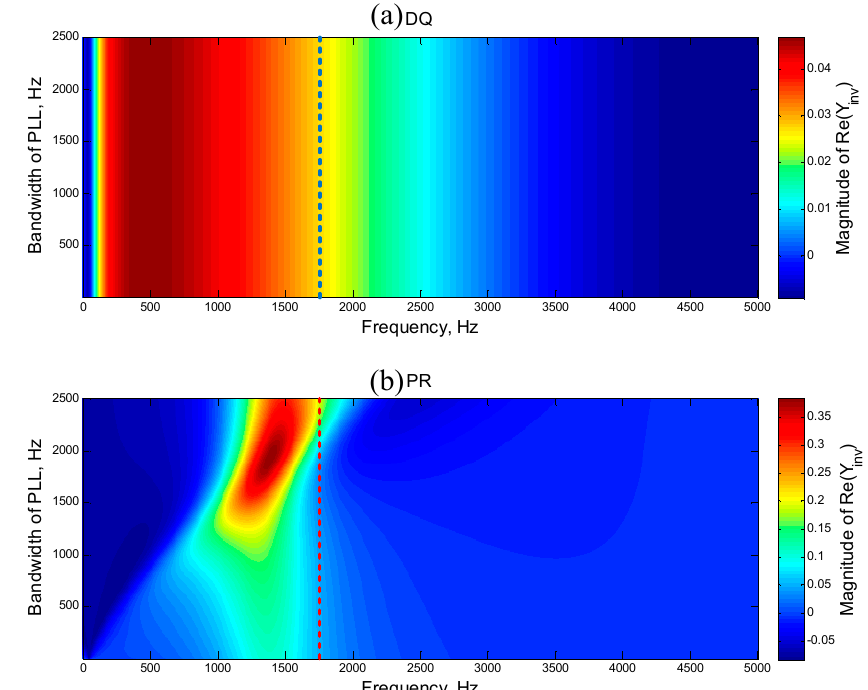
Figure 13. The influence from the PLL bandwidth to Re{Yinv(j ω )}, full band. ( a ) dq-based control method; ( b ) PR-based control method. method; ( b ) PR-based control